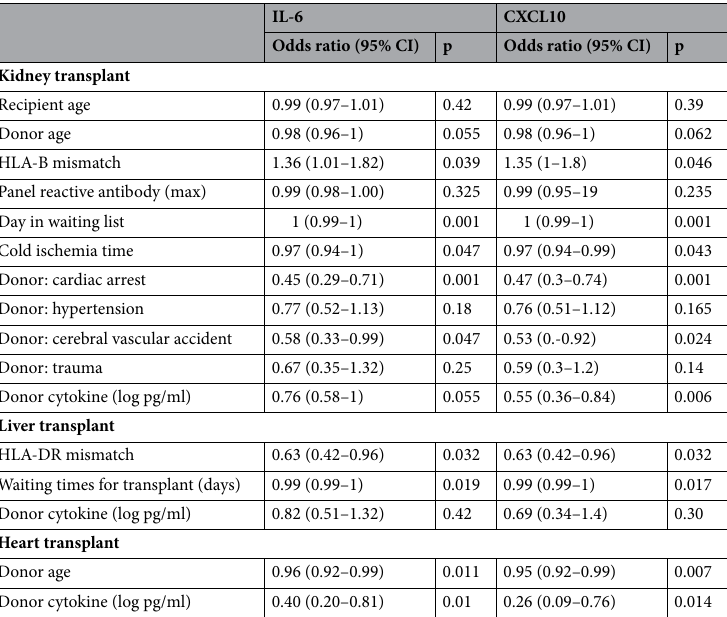
Table 2. Logistic regression models of the predictors of IGF by multivariate analysis. For each cytokine, donor and recipient characteristics with p values < 0.05 in univariate analysis were included in the multivariate